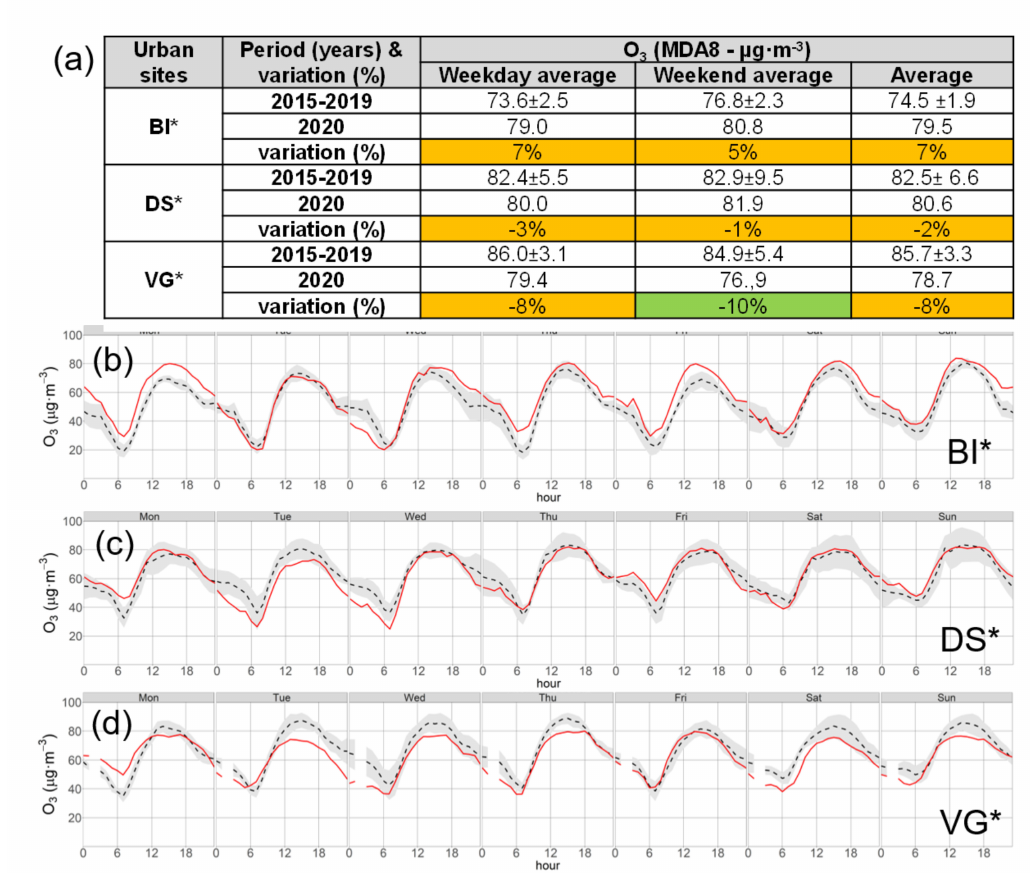
Figure 5. ( Left ) Weekly O 3 averages during the March–June (2020) lockdown period and the corresponding 2015–2019 inter-annual averages in the urban BI* ( a ) and VG* ( b ) monitoring stations. ( Right ) Same type of representation for the PM 10 weekly averages in BI* ( c ) and VG* ( d ).